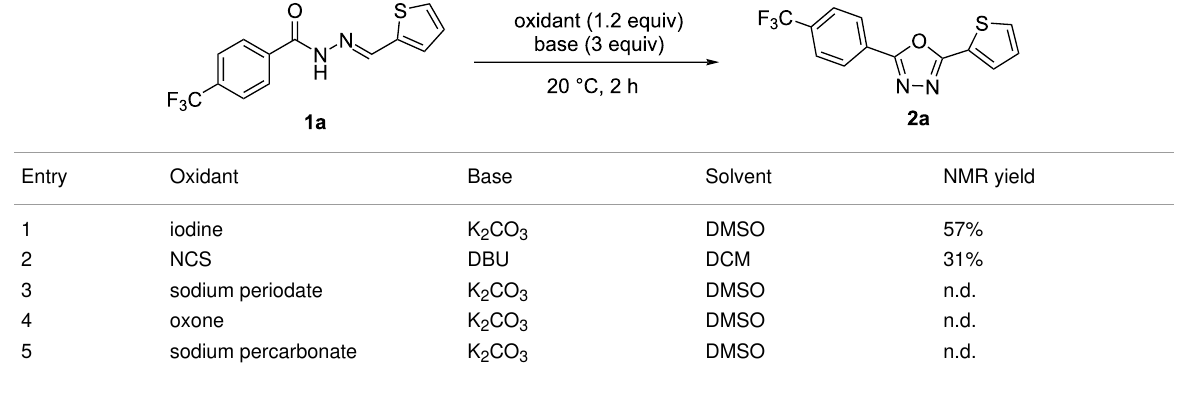
Table 1: Screening of oxidants for cyclisation of acyl